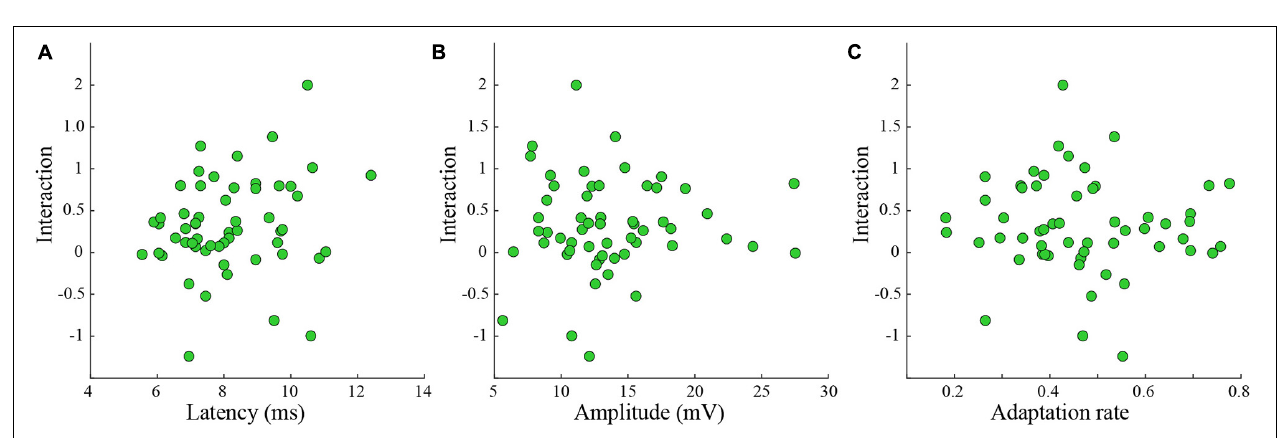
FIGURE 4 | The interaction level was not correlated to various response parameters. (A–C) Interaction was not correlated either to latency (A) , amplitude (B), or adaptation index (C) (rank-sum p > 0.05 for n = 56 tested